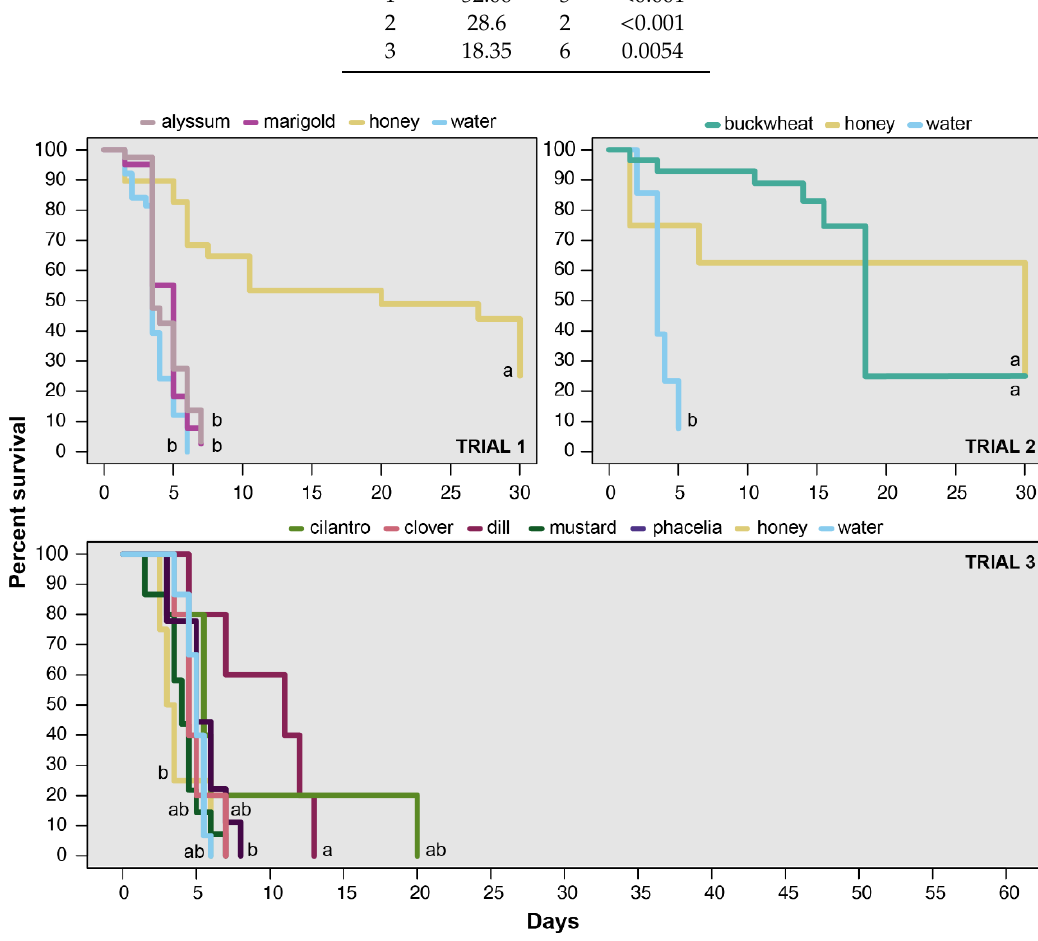
Figure A1. Survival curves of male Trissolcus japonicus fed flower treatments, honey, or water inside vials in the lab. Per results of log-rank analysis and post-hoc tests, lines with different letters are significantly different from each other.